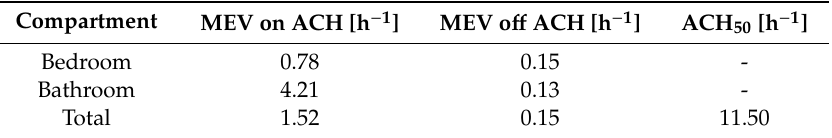
Table 7. Average ACH and ACH 50 results.